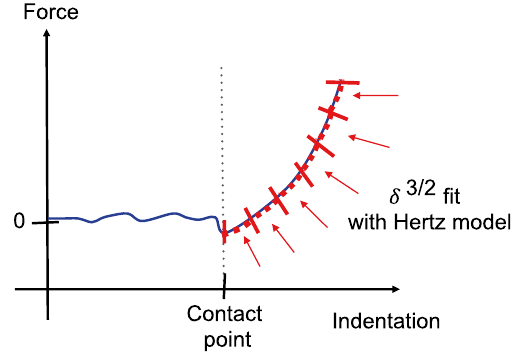
Fig. 1 Principle of the stepwise analysis of a force-distance curve. The local fits are indicated in red. The indentation depth is calcu- lated as the distance from the contact point